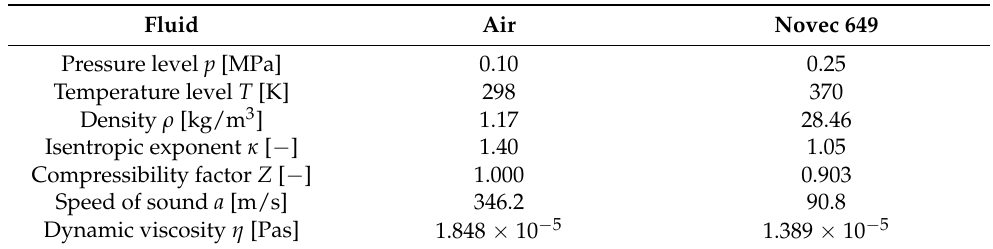
Table 2. Thermophysical properties of dry air and Novec 649 TM at typical pressure and temperature levels (calculated using REFPROP